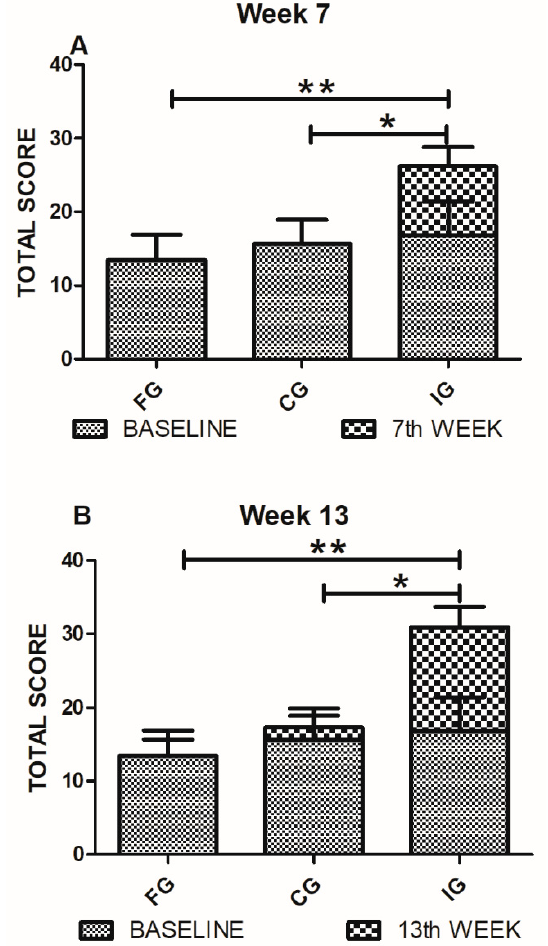
Figure 3. GMFD (standing) evaluations of FG, CG, and IG. ( A ) Standing evaluations on the seventh-week show a significant improvement of IG-patients compared to FG and CG ones. Analysis was performed by the Mann Whitney U test, * p = 0.003 ** p = 0.0004. ( B ) The standing evaluations at 13th-week show a significant improvement of the IG compared to the FG and CG groups. Analysis by the Mann Whitney U test, * p = 0.003 ** p = 0.0002. Bars represent mean ± SD of 10 patients. Baseline values are also shown.